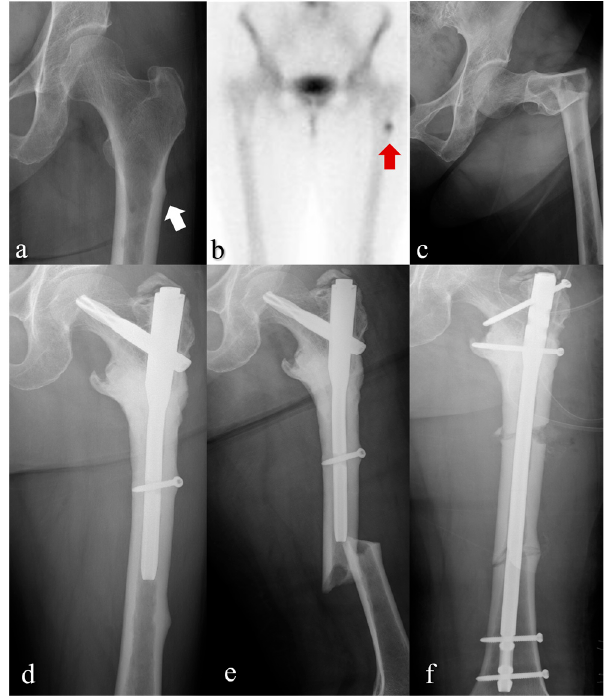
Figure 2. Anteroposterior view radiographs of the left femur ( a , c – f ) and a bone scan image ( b ) of two consecutive AFFs (arrows) occurred in a patient treated with high-dose bisphosphonates. (AFF: atypical femoral fracture).